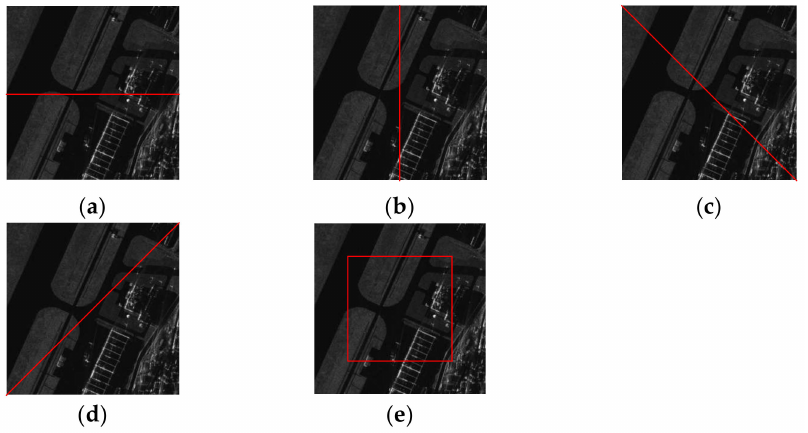
Figure 6. Schematic diagram of sub-region division: ( a ) Vertical direction. ( b ) Horizontal direction. ( c ) 45 ◦ direction. ( d ) 135 ◦ direction. ( e ) Center and periphery.